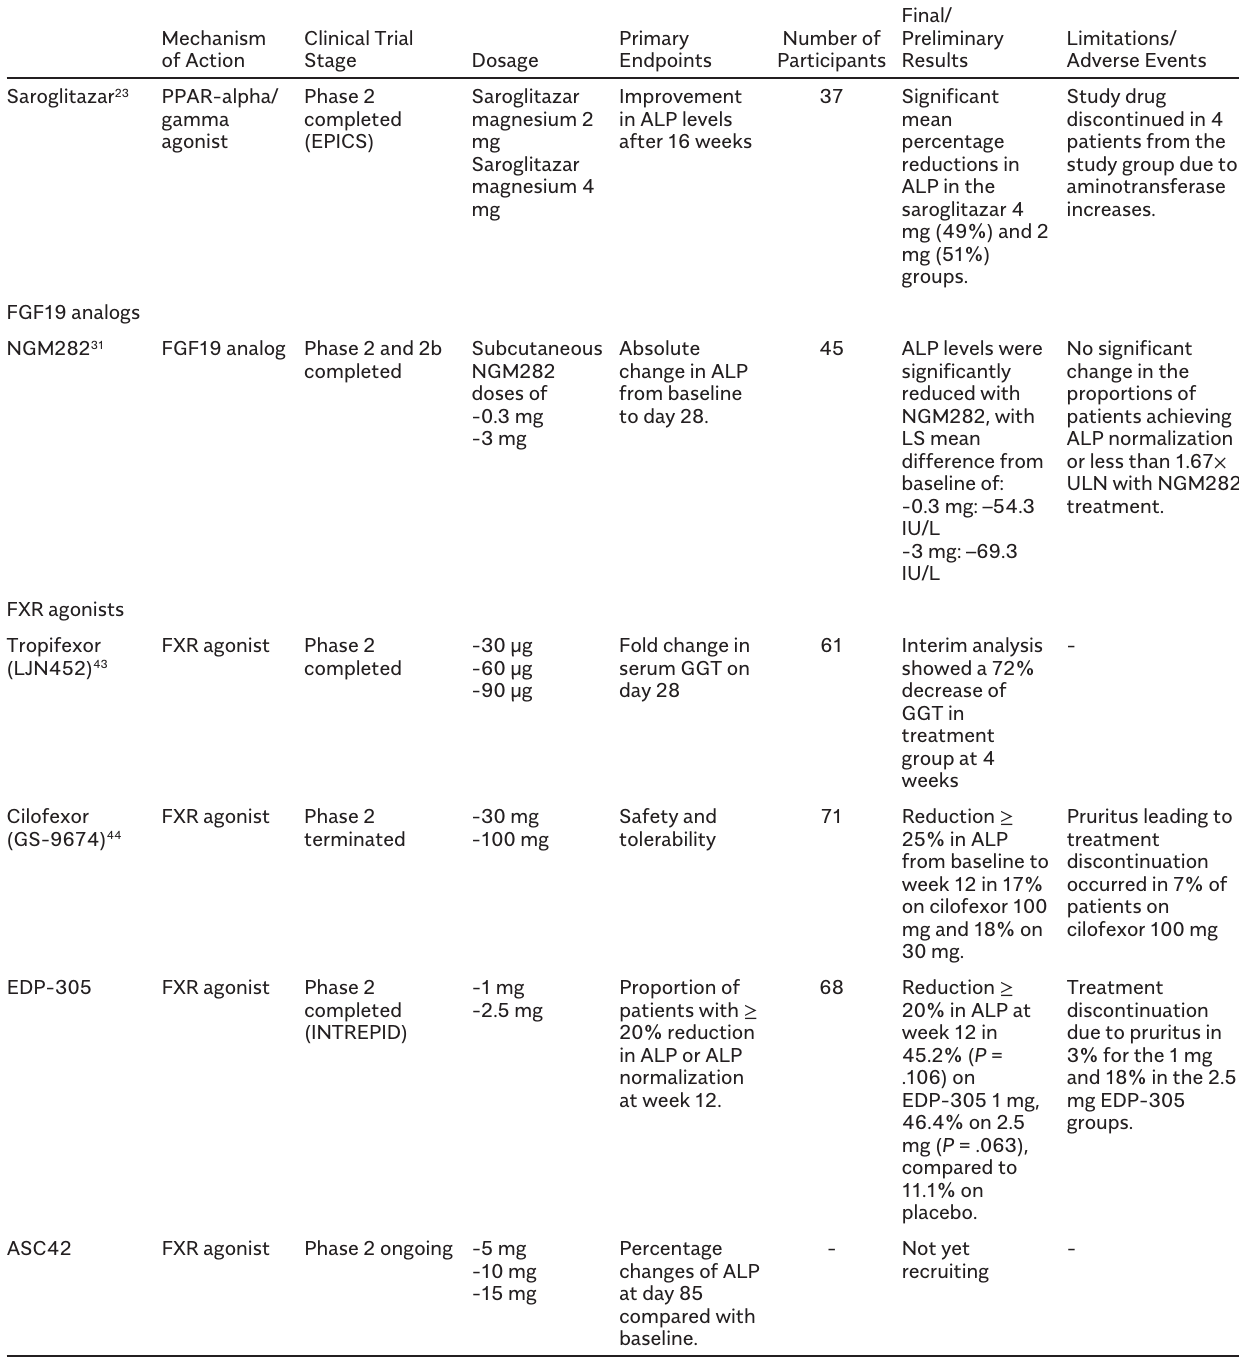
Table 2. Investigational Therapeutics for the Treatment of Primary Biliary Cholangitis